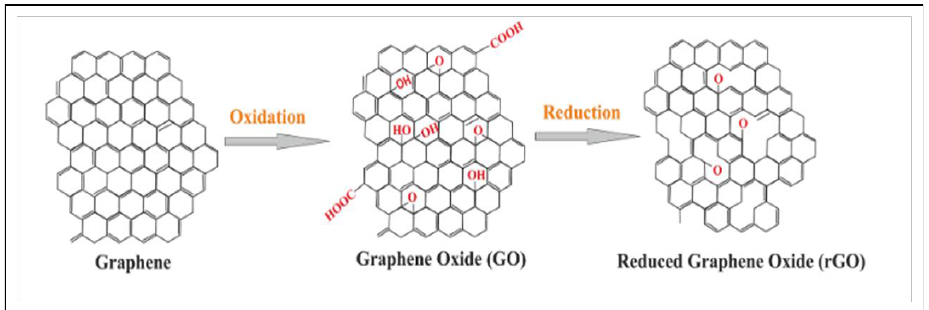
Figure 5. Chemical conversion of graphene-to-graphene oxide (GO) and reduced graphene oxide (rGO). (Reproduced from Ref. [83] with permission from RSC).